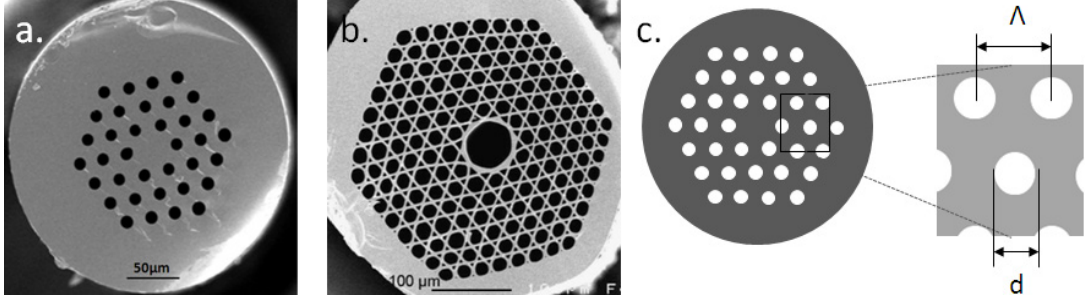
Figure 6. Transverse section of ( a ) Modified total internal reflection microstructured optical fibers (MTIR-MOFs); ( b ) Photonic band gap microstructured optical fibers (PBG-MOFs) [6] and ( c ) schematic diagram of hole diameter, d, hole spacing, Λ